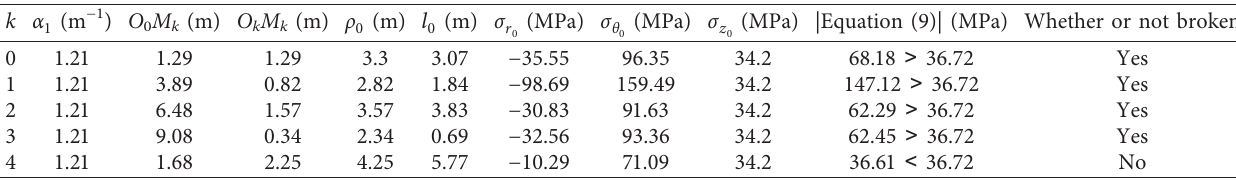
Table 3: Stability analysis results of the Qinling water diversion tunnel.